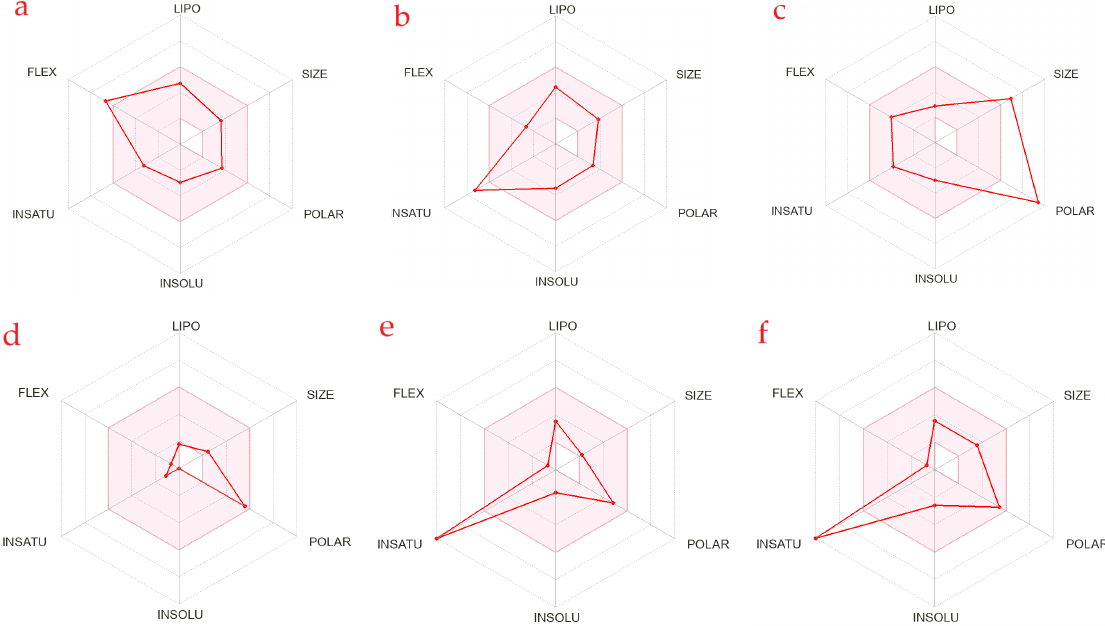
Figure 6. The pink area of the bioavailability radar represents the optimal range for each property. Radars of [6]-gingerol ( a ), 3 (cid:48) ,4 (cid:48) ,5 (cid:48) -trimethoxyflavone ( b ), naringin ( c ), quinic acid ( d ), gallic acid ( e ), and cyanidin ( f ) were